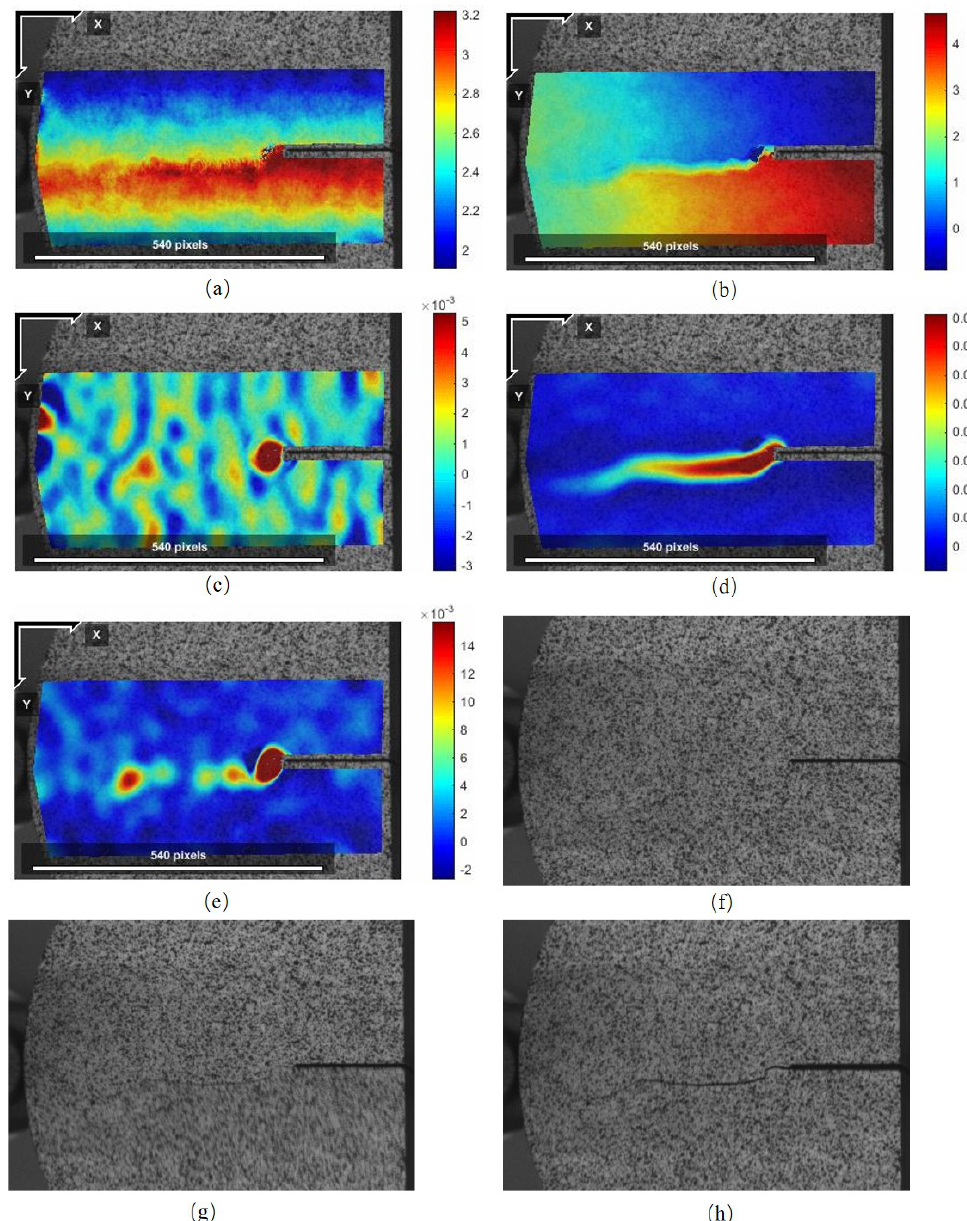
Figure 15. Displacement field, strain field, and photos of specimen A2 before and after the fracture: ( a ) distribution field of vertical displacement U before the occurrence of the A2 fracture; ( b ) distri- bution field of horizontal displacement V before the occurrence of the D2 fracture; ( c ) distribution field of strain ε x before the occurrence of the A2 fracture; ( d ) distribution field of strain ε y before the occurrence of the A2 fracture; ( e ) distribution field of strain ε xy before the occurrence of the A2 frac- ture; ( f ) photo before the occurrence of the A2 fracture (the original 4401th photo); ( g ) photo during the occurrence of the A2 fracture (the original 4402th photo); ( h ) photo after the A2 fracture (the original 4403th photo).